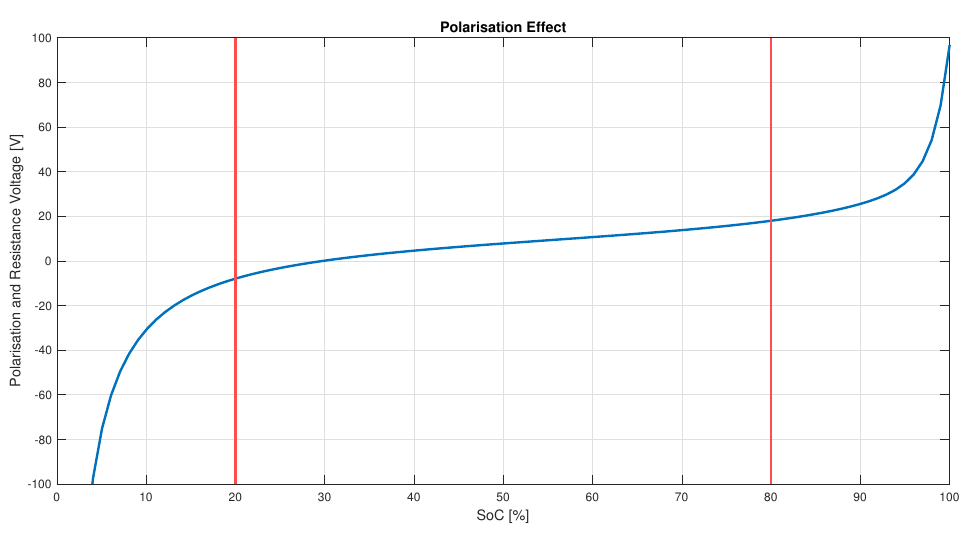
Figure 1. Limited polarization effect between 20% and 80% SoC There are two possibilities associated with external chargers and their control typolo- gies. The first employs a combination of an inverter and a DC-DC converter per